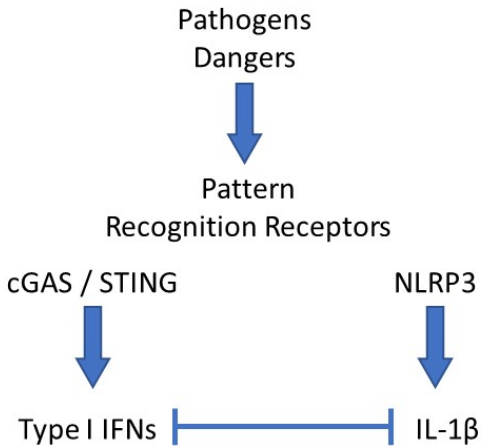
Figure 1. Schematic network of interactions between type I IFNs and IL-1 β . Pathogens- or danger-associated molecular patterns (PAMPs, DAMPs) interact with their cognate pattern recognition receptor (PRRs). In the example shown here, DNA binding and activation of the cGAS/STING pathway leads to type I interferons (IFNs) secretion, while monosodium urate (MSU) crystals activate the NLRP3 inflammasome, which induces IL-1 β release. In most cases, both cytokines exert antagonistic activities, mutually repressing their expression levels by various mechanisms.